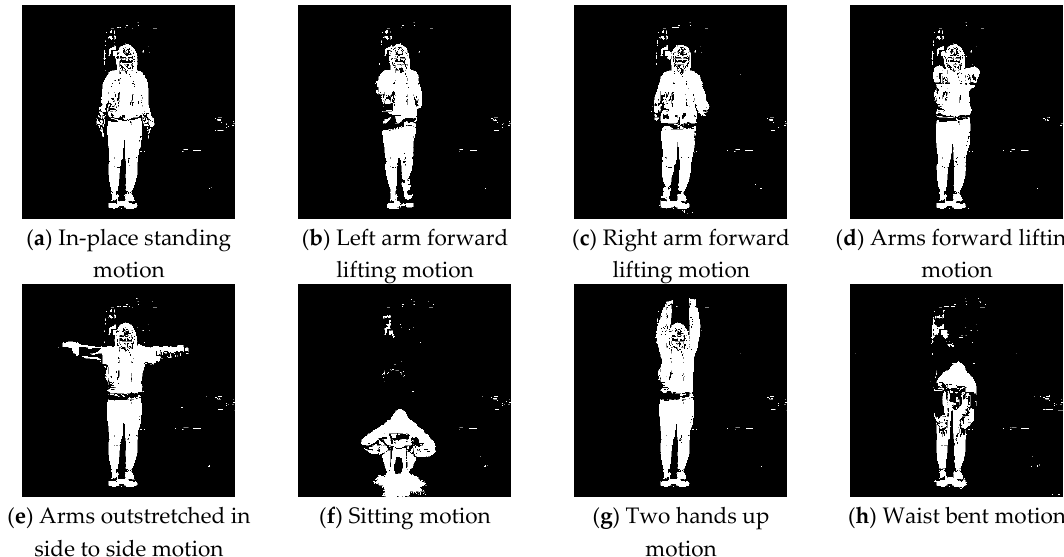
Figure 9. Difference images generated by the difference between the background image and the Figure 9. Di ff erence images generated by the di ff erence between the background image and the collected RGB images. collected RGB images.